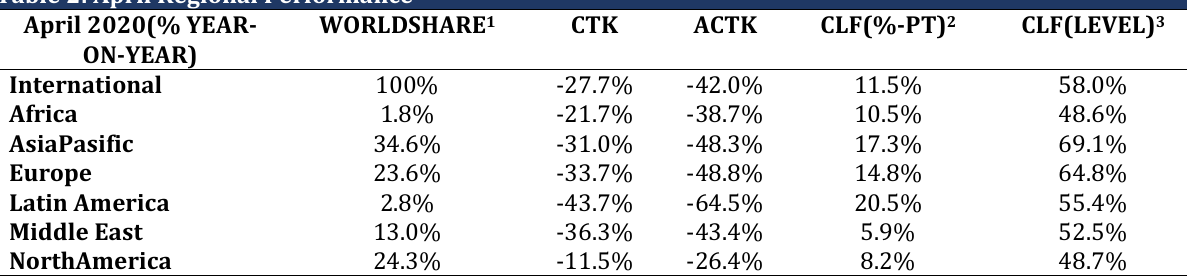
Table 2: April Regional